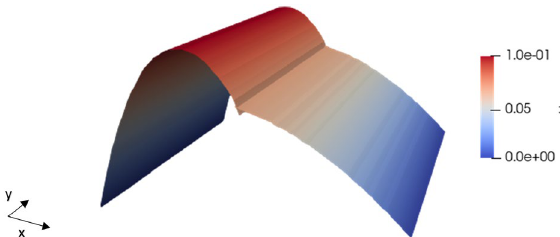
Fig. 13 Elevation of the numerical